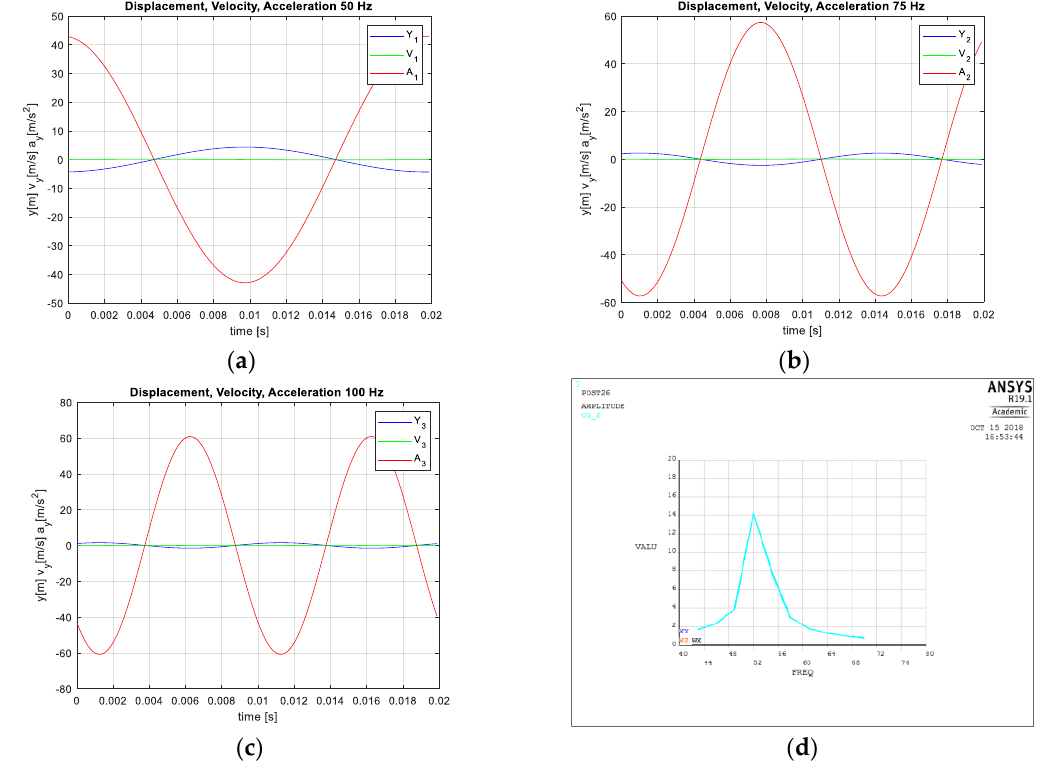
Figure 7. Laws of motion, speed, and acceleration of the free end of the upper support at 50 Hz ( a ), at 75 Hz ( b ), and at 100 Hz ( c ). Frequency response of the beam according to Ansys ® evaluations ( d